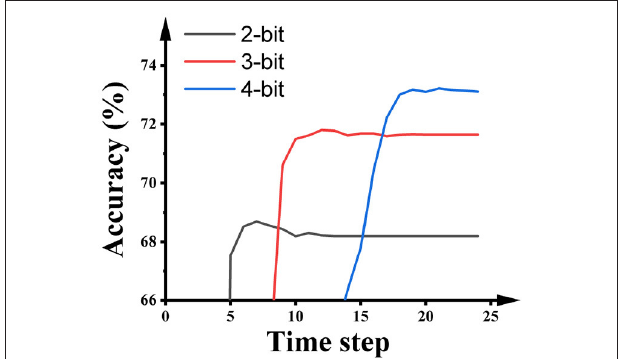
FIGURE 6 | The impact of the activation precision during the quantization training of ResNet-50 on the performance of SNNs on ImageNet.